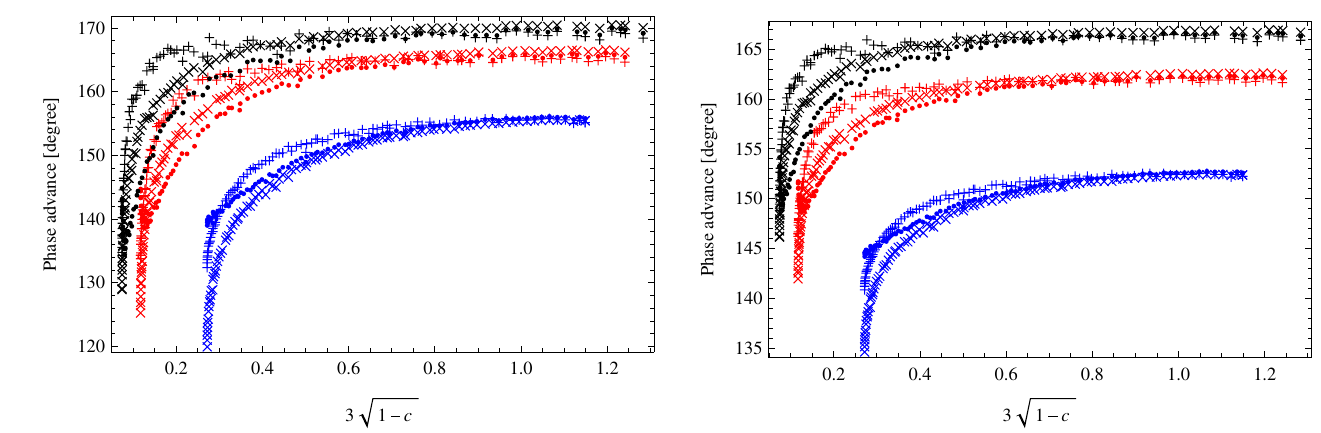
FIG. 9. Phase advances in the dispersion matching section in symmetric double-bend cells for AME ( (cid:2) ), TME ( þ ), and EME ( (cid:7) ) under three different peak fields 2 (blue), 4 (red), and 6 (black). Phase advances for uniform dipoles are 122 (cid:6) , 133 (cid:6) , and 133 (cid:6) , respectively.